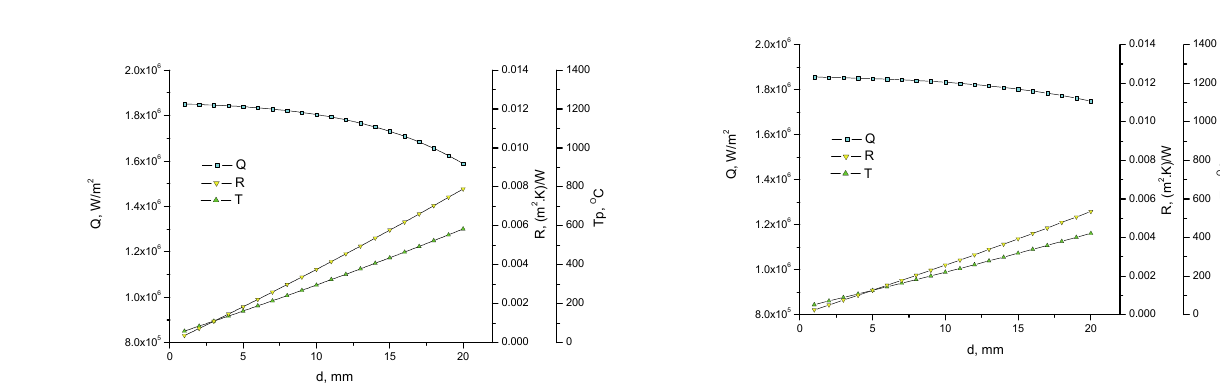
Figure 8: Heat losses, surfaces temperature and thermal resistance of insulation as a function of chrome-magnesite insulation thickness